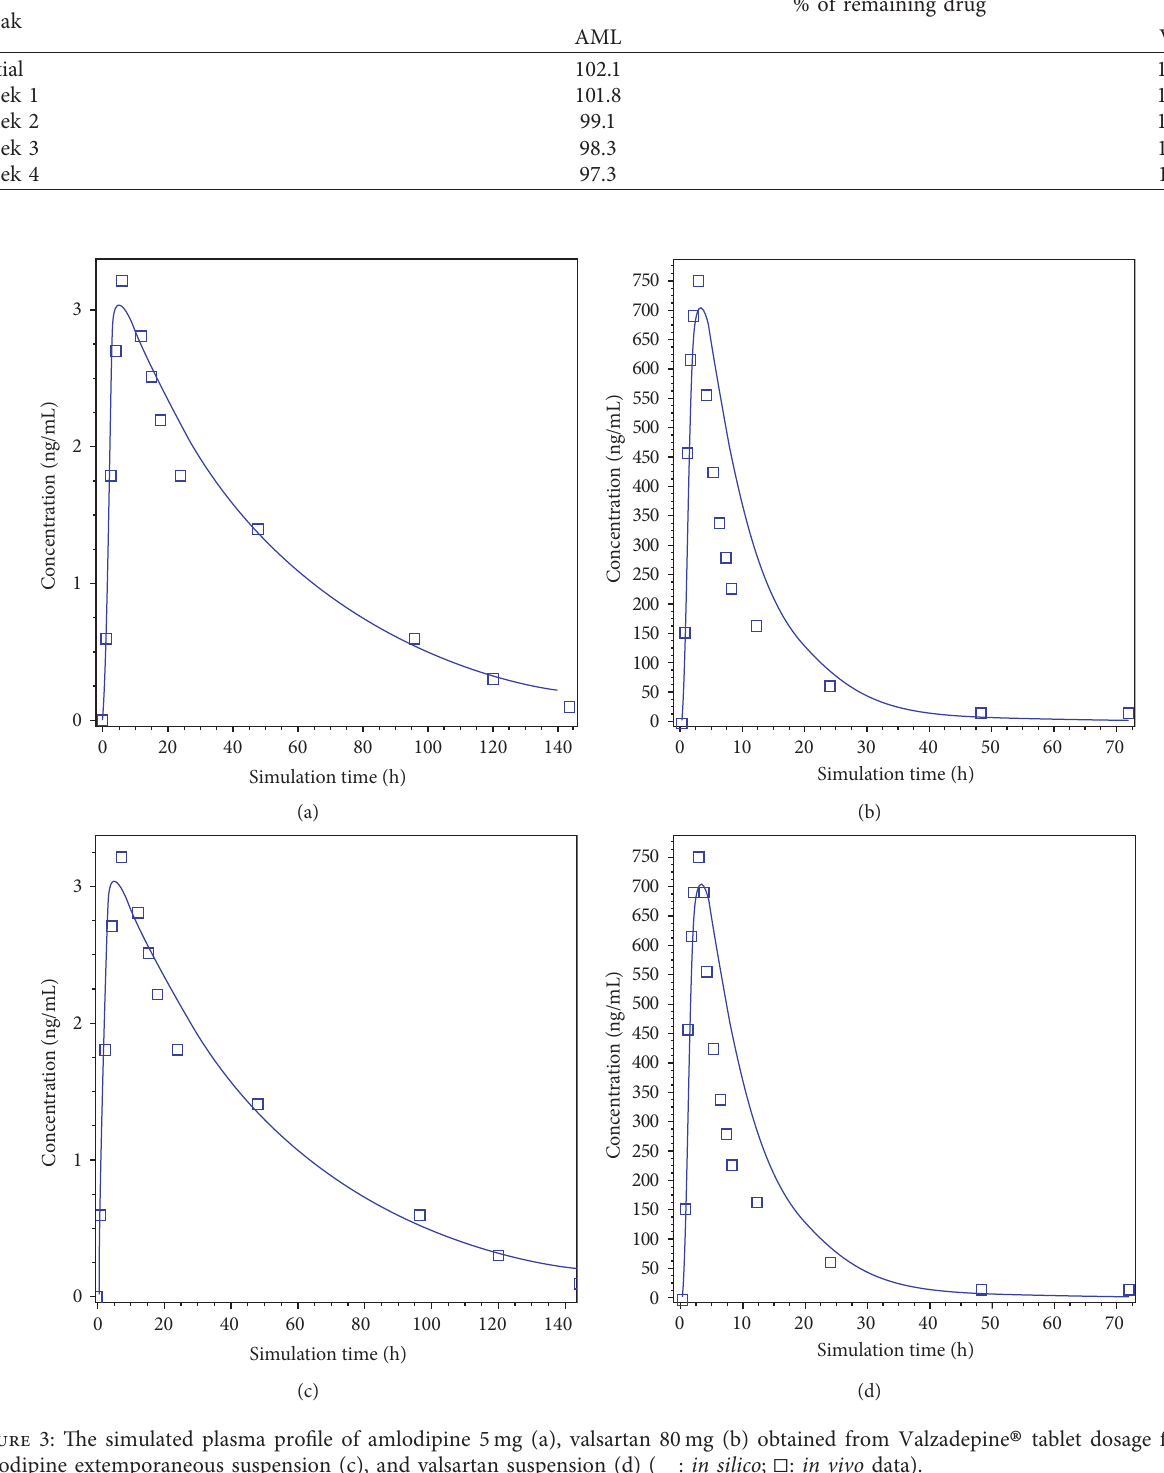
Figure 3: The simulated plasma profile of amlodipine 5 mg (a), valsartan 80 mg (b) obtained from Valzadepine ® tablet dosage form, amlodipine extemporaneous suspension (c), and valsartan suspension (d) (__: in silico ; □ : in vivo data).